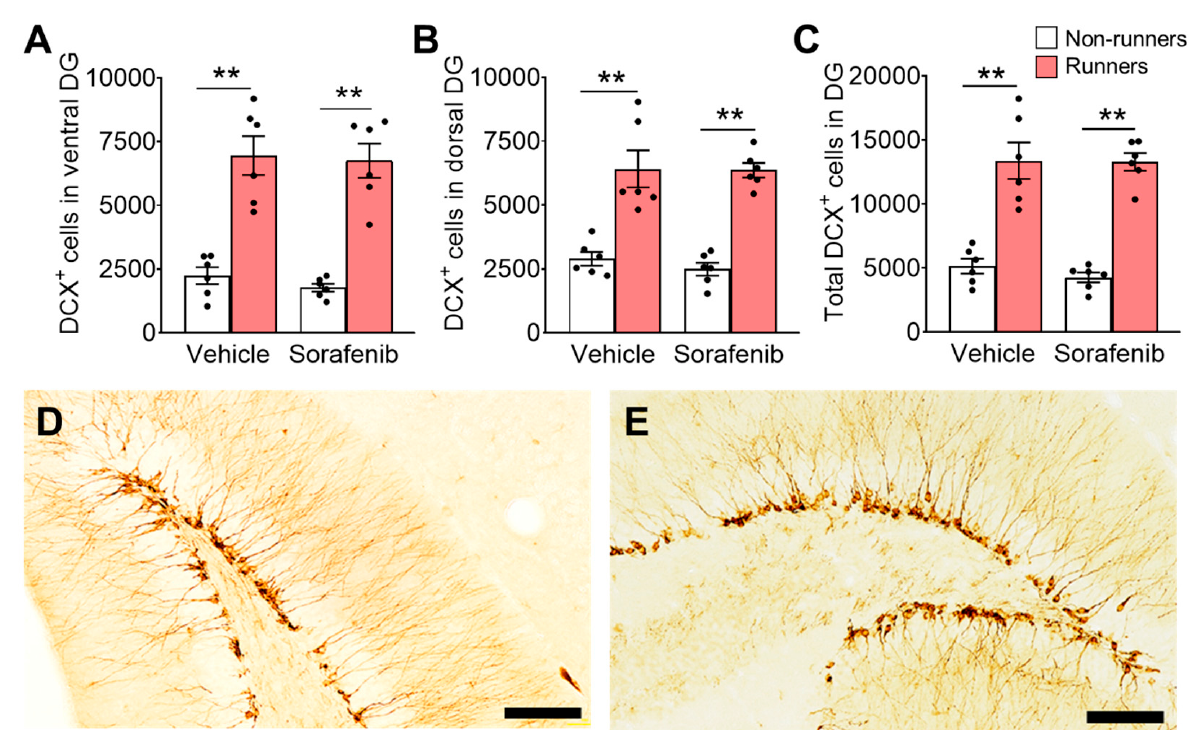
Figure 5 . Voluntary running promoted immature neuron numbers in DG, but sorafenib showed no effect. ( A – C ) Sorafenib administration did not affect immature neuron number in DG, while runners increased immature neurons in the ( A ) ventral, ( B ) dorsal, and ( C ) whole DG of sorafenib-treated and vehicle-treated mice (Tukey’s post hoc: ** p < 0.005 vs. Non-runners). ( D , E ) Representative images of DCX positive cells in the ( D ) ventral and ( E ) dorsal DG (Scale bars, 100 μ m in 200×). Results were expressed as mean ± SEM. n = 6 per group.